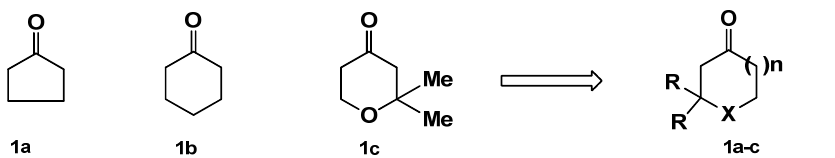
Figure 2. The structure of starting cyclic ketones 1a – c . 1a : X = CH 2 , n = 0, R = H, b : X = CH 2 , n = 1, R = H, c : X = O, n = 1, R =